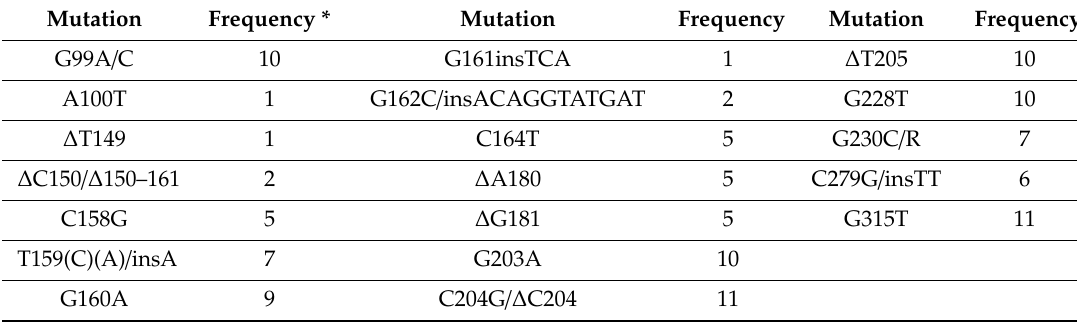
Table 8. Frequency of mutations in the noncoding control region of